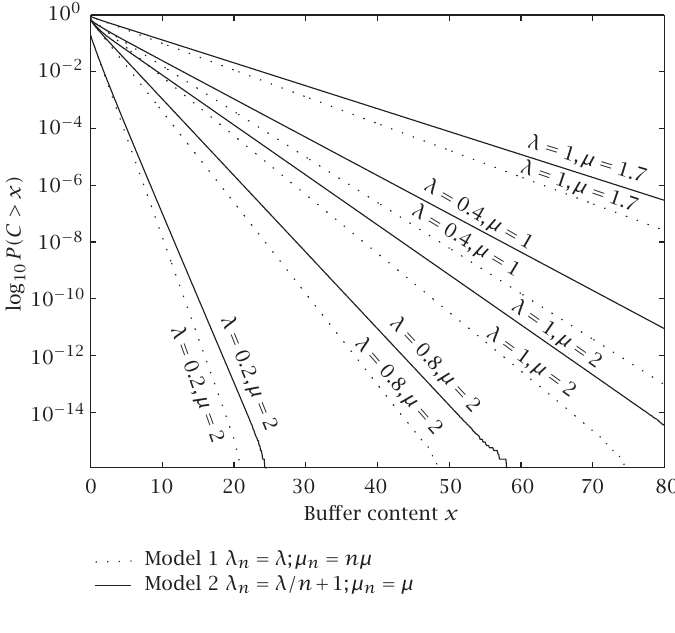
Figure 7.1 . Buffer content distribution with r